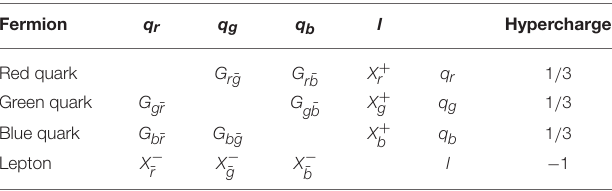
TABLE 3 | SU(2) representation for exchange of up quark with down quark by help of the U gauge boson. Fermion u d Electric charge Up quark U